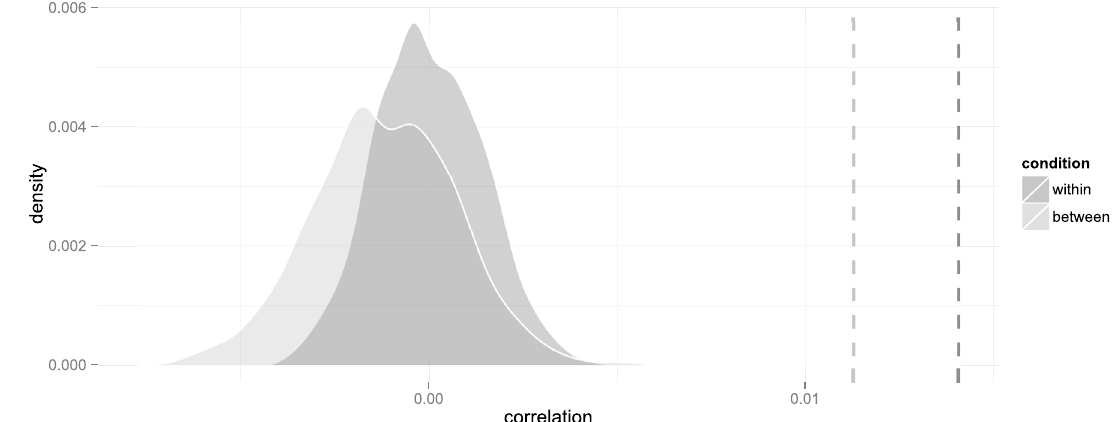
Fig 5. Probability distributions of correlations in the within- and between-group designs under the null hypothesis that choices are randomly allocated irrespective of whether the pairs of students are both immigrants or natives or one is an immigrant and the other a native. The dashed lines represent the observed